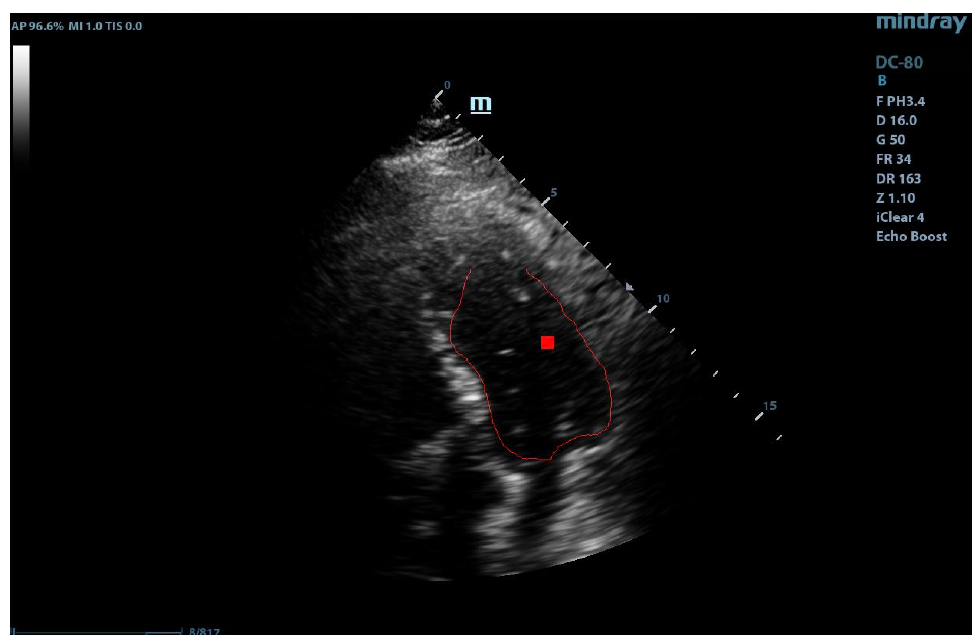
Figure 5. Complete application of the anisotropic Gabor–Hough